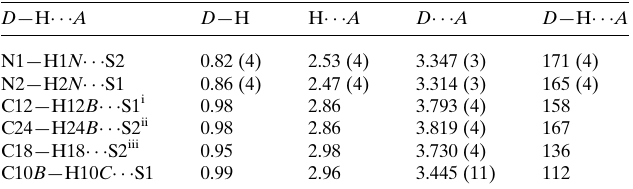
Table 2 Hydrogen-bond geometry (A˚ , (cid:5) ) for (II).